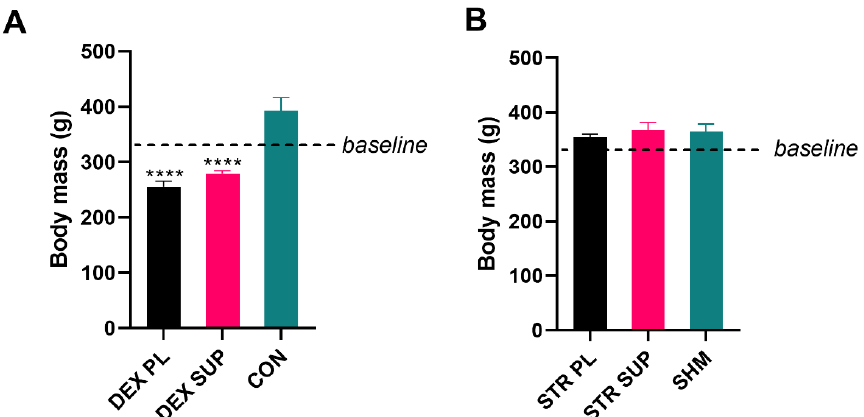
Figure 4. The body mass at the end of the experiment in DEX-treated ( A ), and stressed ( B ) rats. Results are expressed as mean ± SEM. DEX PL ( n = 7), DEX SUP ( n = 8), CON ( n = 6), STR PL ( n = 9), STR SUP ( n = 9), SHM ( n = 6), **** p < 0.0001 vs. CON. DEX PL: dexamethasone-treated group supplemented with placebo; DEX SUP: dexamethasone-treated group supplemented with vitamin D 3 ; CON: control group; STR PL: cold water immersion group supplemented with placebo; STR SUP: cold water immersion group supplemented with vitamin D 3 ; SHM: sham cold water immersion group.